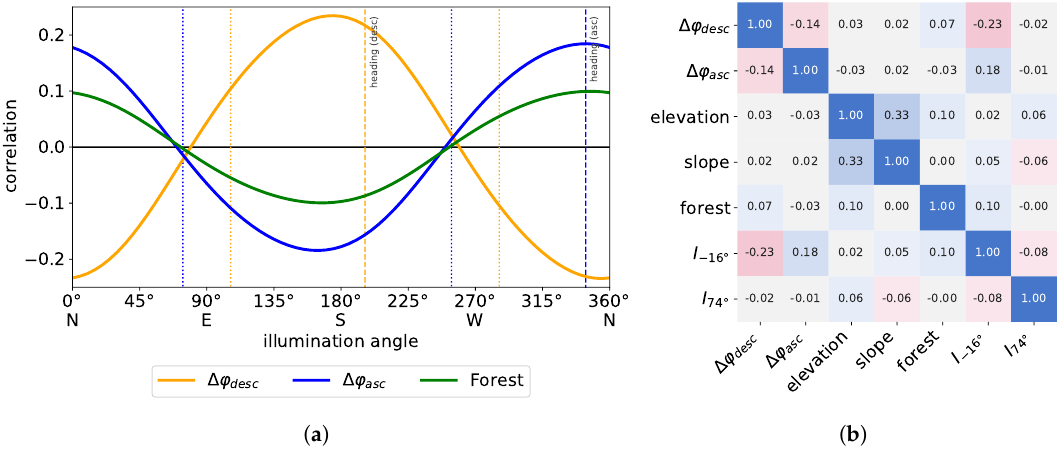
Figure 10. ( a , c ) depict hillshade images for illumination (azimuth) angles of This corresponds to the perceived illumination intensity for a source pointed in azimuth direction ( a ) of the ascending orbit and in perpendicular orientation ( c ). The histograms to the right of the hillshade images ( b , d ) show the distribution of this illumination intensity separately for forest and non-forest.